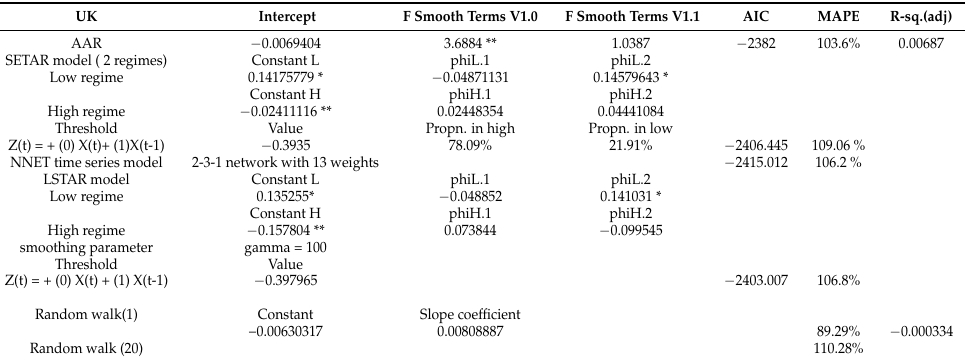
Table 7. Non-linear models-UK.